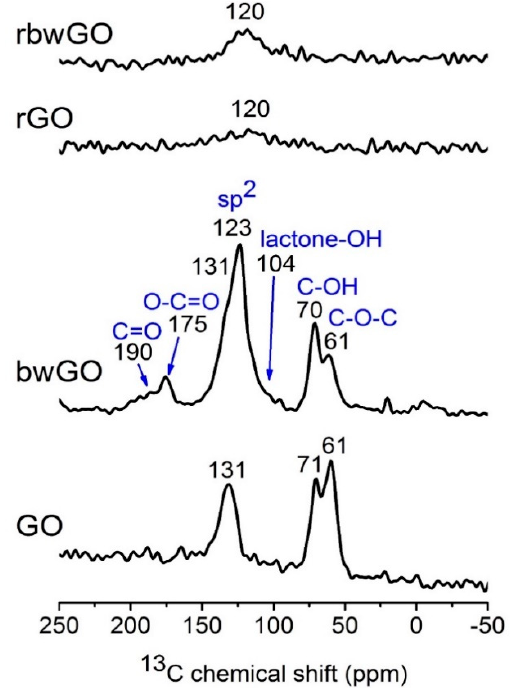
Figure 4. Direct excitation 13 C MAS NMR spectra of graphene oxide samples.